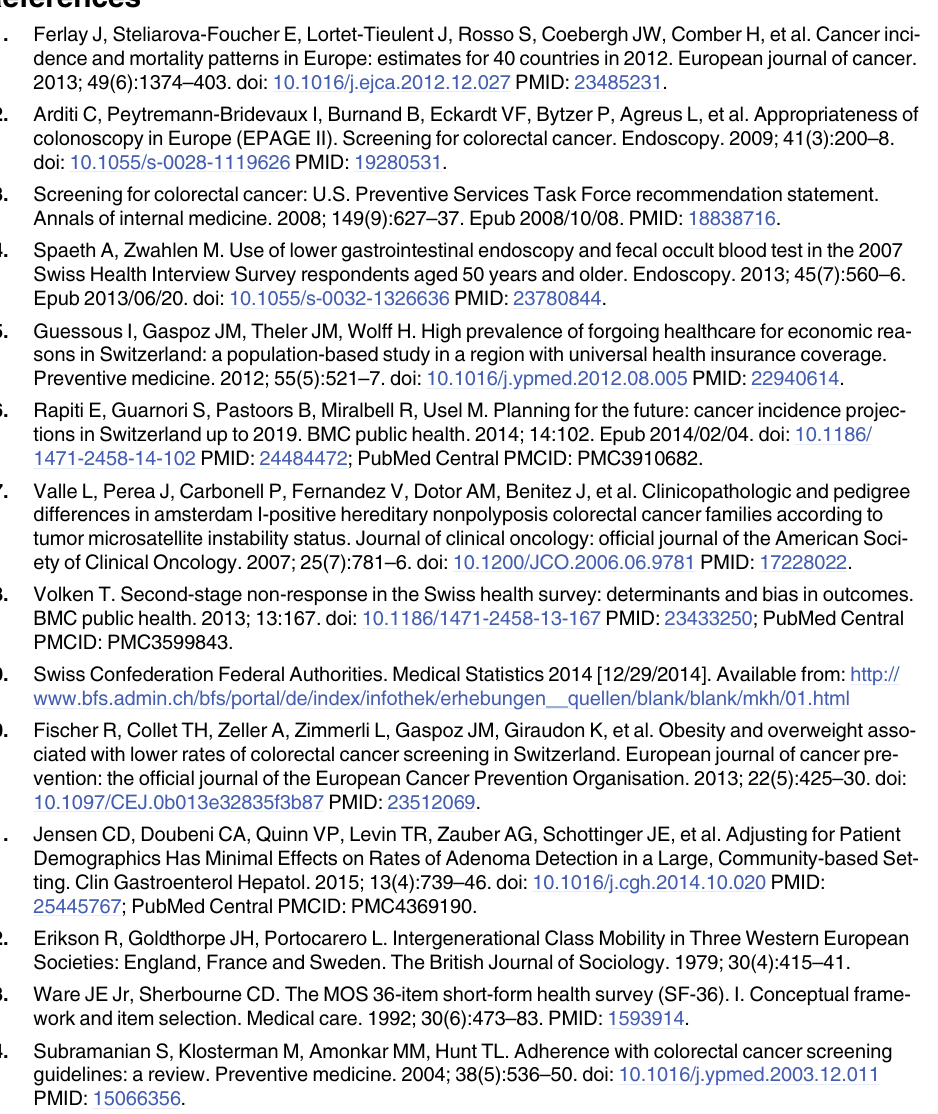
S2 Table. Adjusted and weighted prevalence ratios of colorectal cancer screening (for screening reasons) among adults aged 50 – 75 in the labor force from the Swiss Health Inter- view Survey (SHIS) 2007 and 2012 (n =